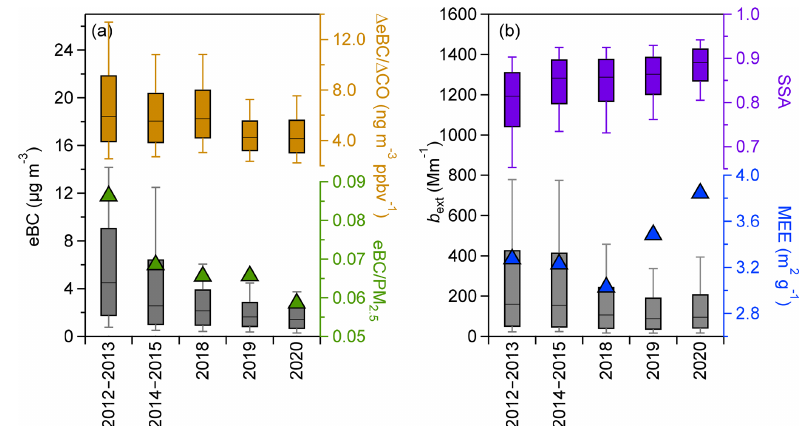
Figure 1. Annual variations of (a) eBC, (cid:49) eBC /(cid:49) CO, and eBC / PM 2 . 5 and (b) b ext , SSA, and MEE. The median (horizontal line), mean (markers), 25th and 75th percentiles (lower and upper box), and 10th and 90th percentiles (lower and upper whiskers) are also shown.